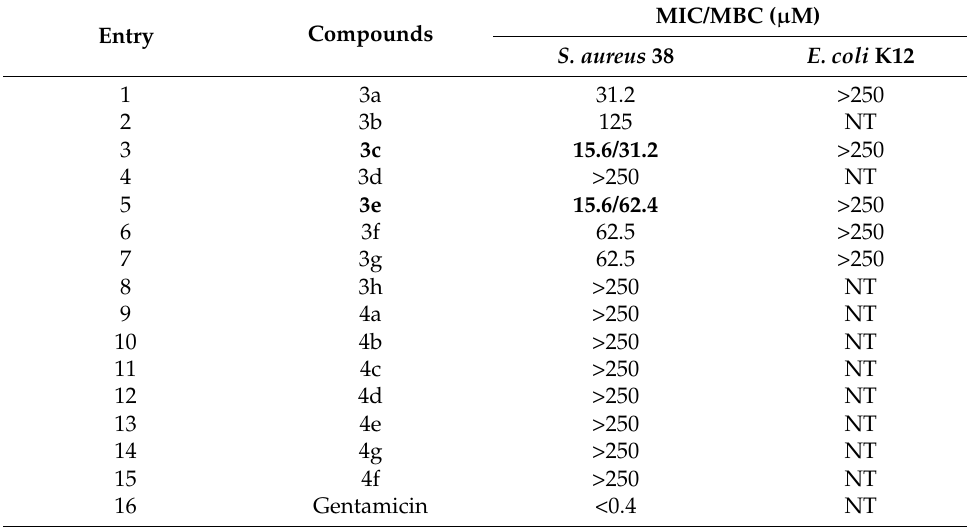
Table 3. MIC determined for compounds against Gram-positive S. aureus (SA38) and Gram-negative bacteria ( E. coli K12). NT-Not